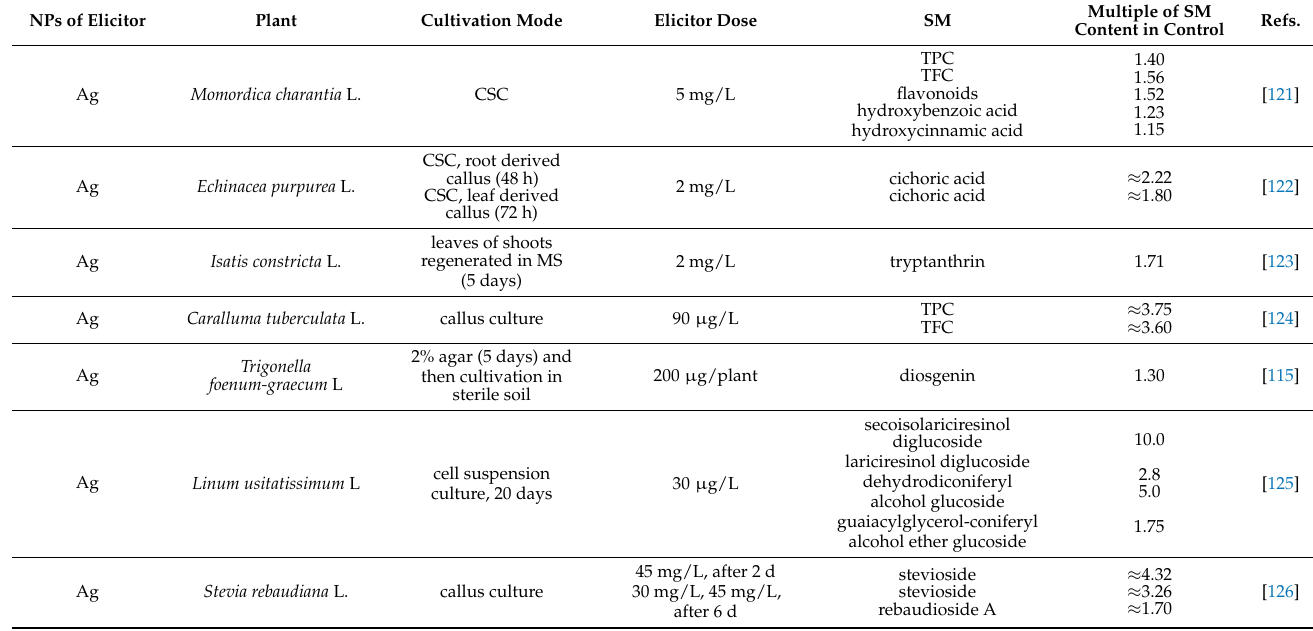
Table 1. Enhanced production of secondary metabolites (SM) of medicinal plants elicited by various NPs using in vitro cultures and plants grown in soil or hydroponic solutions compared to corresponding bulk elicitors. (CSC = cell suspension culture, TPC = total phenolic content, TFC = total flavonoid content, MS = Murashige and Skoog medium, EO = essential